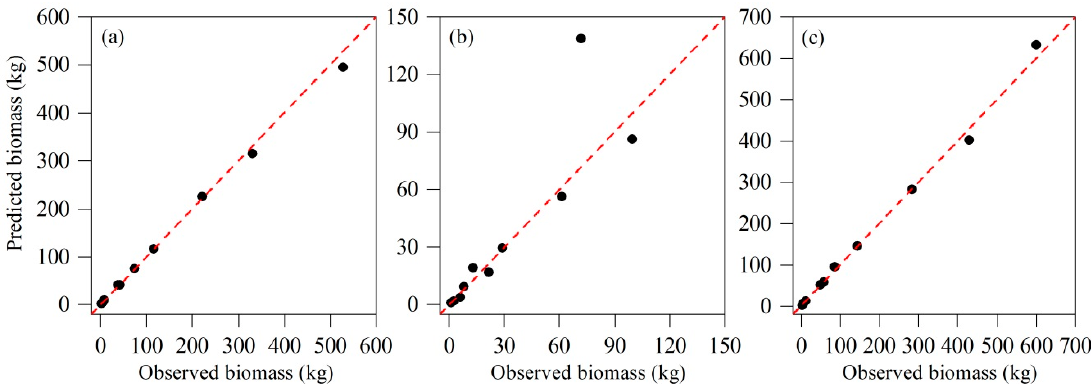
Figure 5. Scatterplots of the observed ( x -axis) and the predicted ( y -axis) values for the stem (wood plus bark) ( a ), crown ( b ) and aboveground ( c ) biomass of the selected additive systems of biomass equations. The dashed line in red color indicates the 1:1 equivalence.